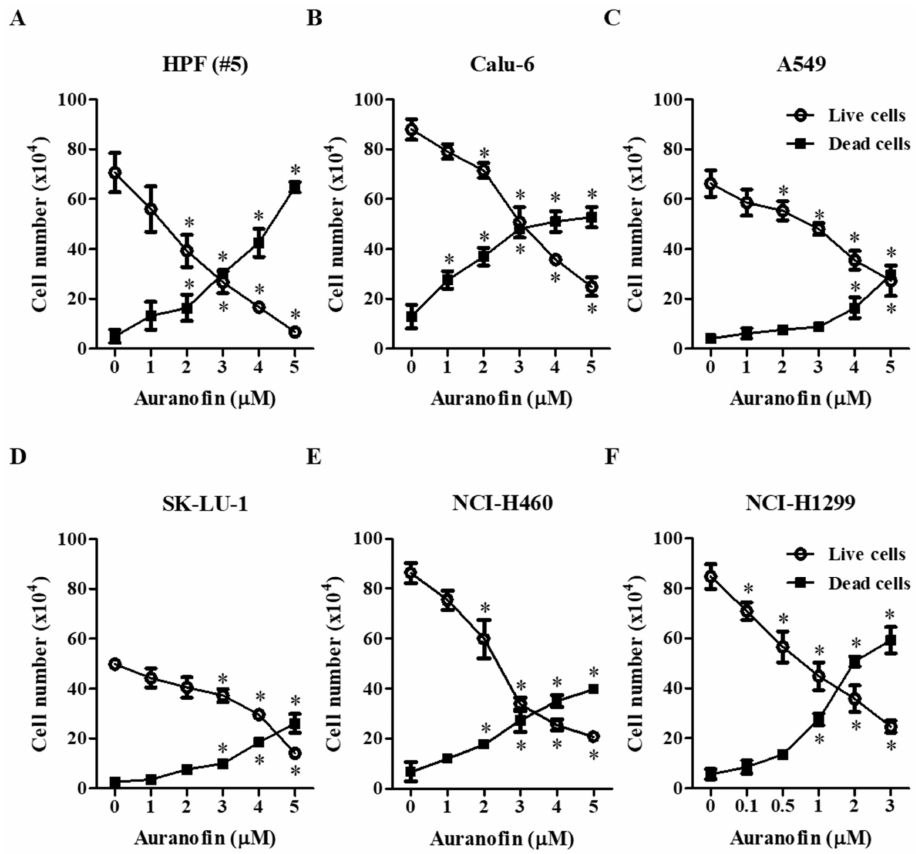
Figure 1. Effects of auranofin on cell proliferation in lung cancer cells. Exponentially growing cells were incubated in the presence of the indicated concentrations of auranofin for 24 h. Live and dead cell numbers were evaluated by trypan blue staining cell counting. Graphs illustrate the numbers of live and dead cells in normal HPF cells ( A ) and cells from the lung cancer cell lines Calu-6 ( B ), A549 ( C ), SK-LU-1 ( D ), NCI-H460 ( E ), and NCI-H1299 ( F ). * p < 0.05 compared with auranofin-untreated control